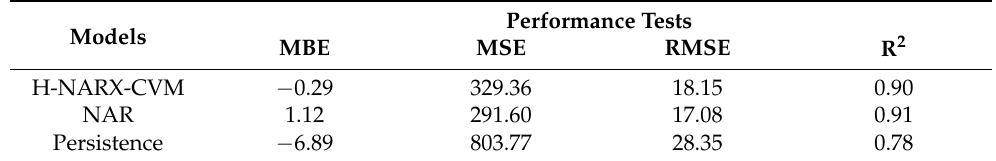
Table 13. Results of the performance tests for October 19.